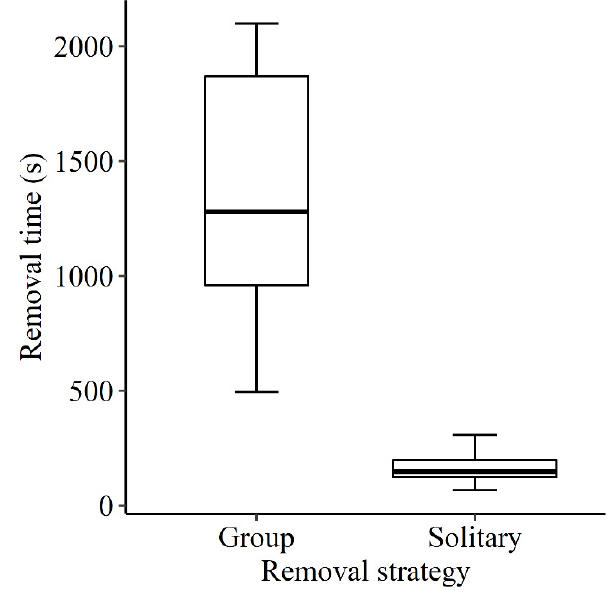
Fig 3 . Solitary remover ants remove diaspores faster than group removal ants. The x -axis indicates the removal strategy, and the y -axis indicates the removal time in seconds. The centreline of each boxplot indicates the median of all values, and the boxes indicate the first quartile (median of the values above the central median) and third quartile (median of the values below the central median). The vertical lines of each boxplot are the Tukey-style whiskers (1.5 × interquartile range).